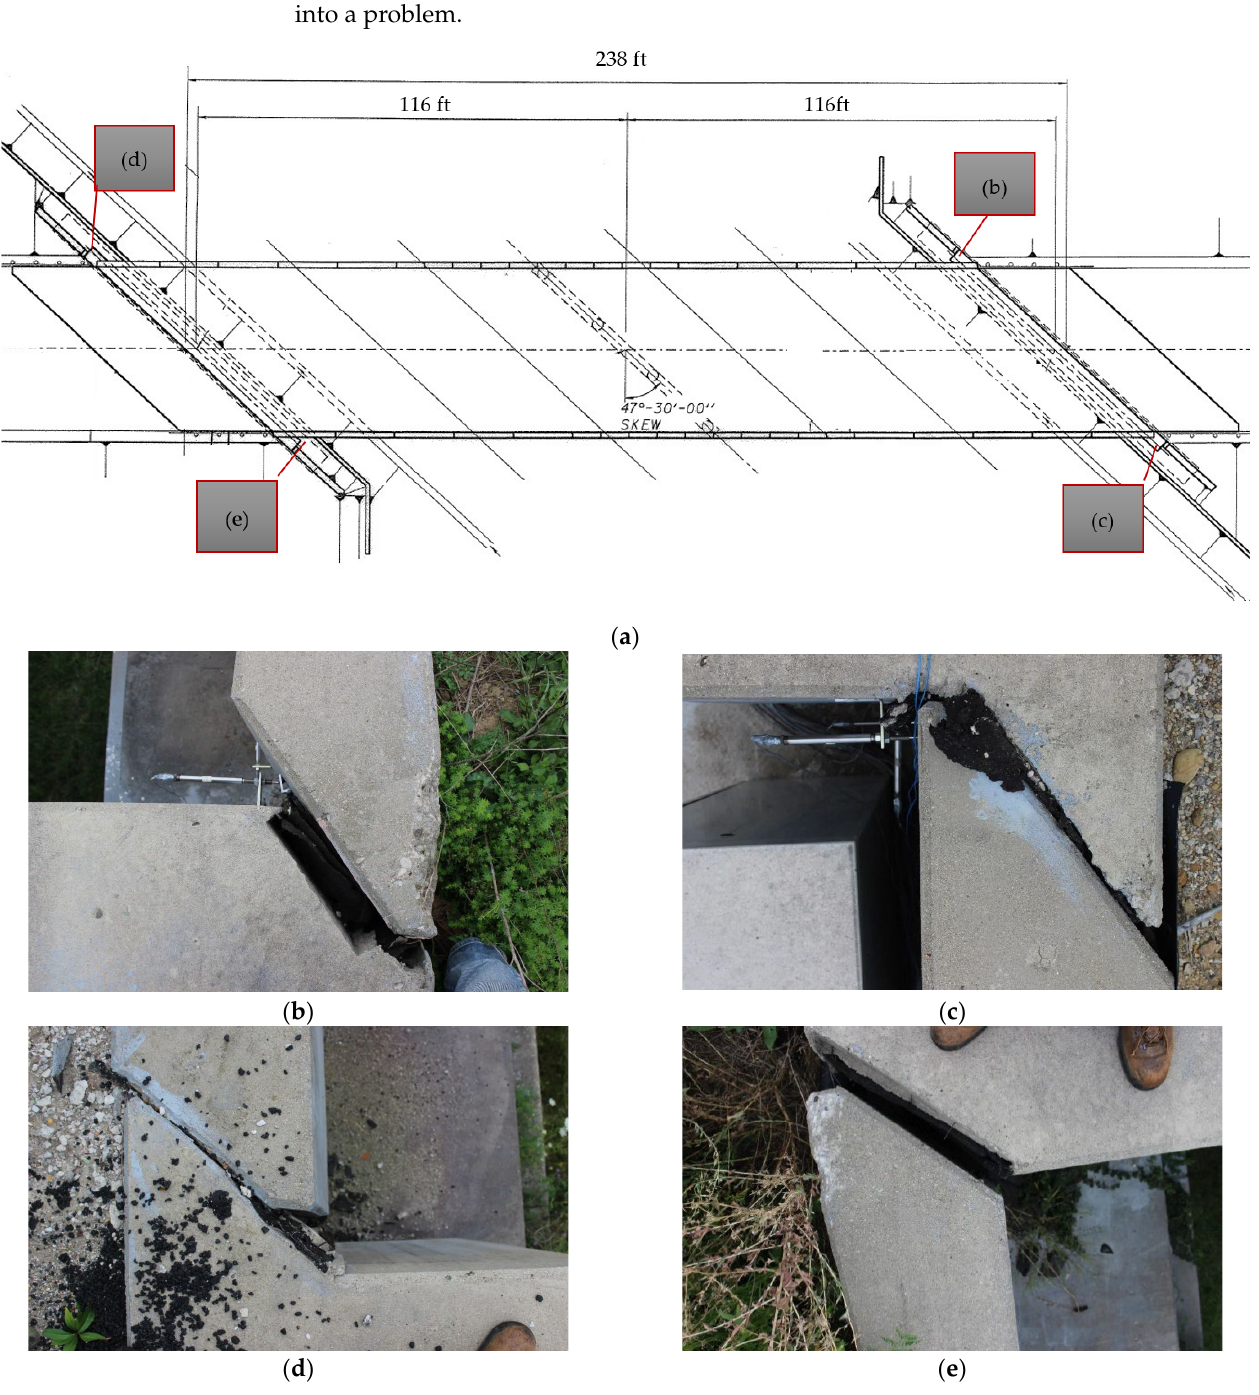
Figure 5. Wingwall joint opining: ( a ) overview; ( b ) forward obtuse corner of bridge; ( c ) forward acute corner of bridge; ( d ) rearward acute corner of bridge; and ( e ) rearward obtuse corner of bridge.